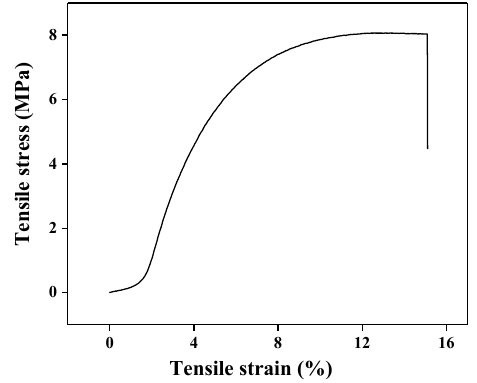
Figure 6. Stress-strain curve of the obtained PBLG-PPG-PBLG film.